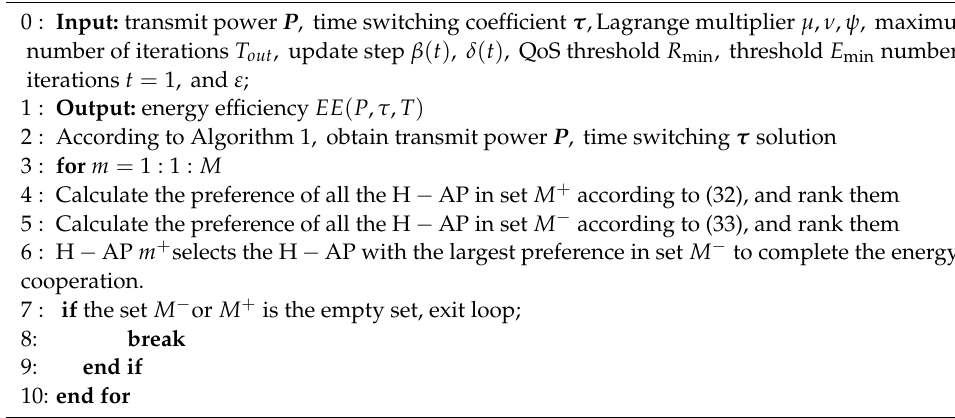
Algorithm 2. Joint power allocation, time switching and energy cooperation algorithm